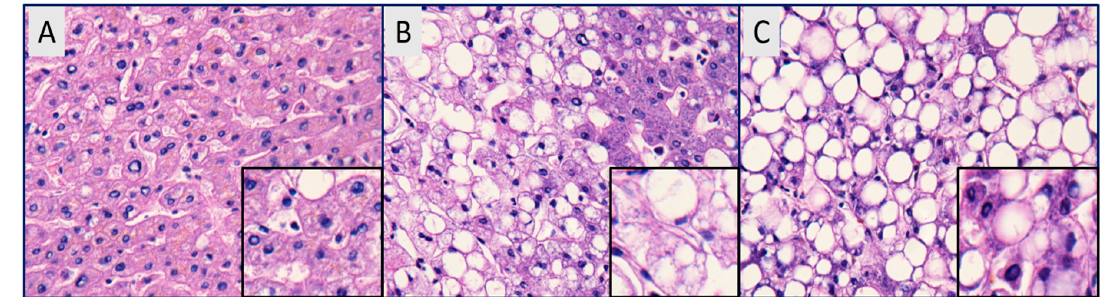
Figure 1. Hematoxylin and eosin staining of ( A ) normal liver with uniform chord-like arrangements of hepatocytes, ( B ) nonalcoholic fatty liver (NAFL) with lipid droplets, and ( C ) nonalcoholic steatohepatitis (NASH) with significant hepatic steatosis and infiltration of lymphomononuclear inflammatory cells [10].